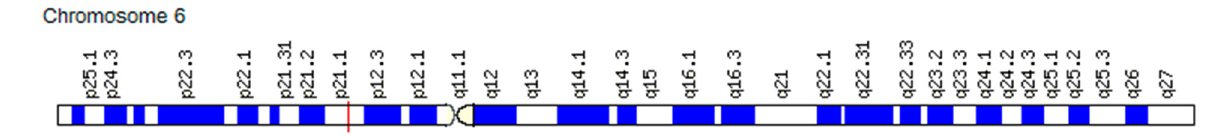
Figure 1. Localization of the VEGF gene on chromosome 6p21.1.